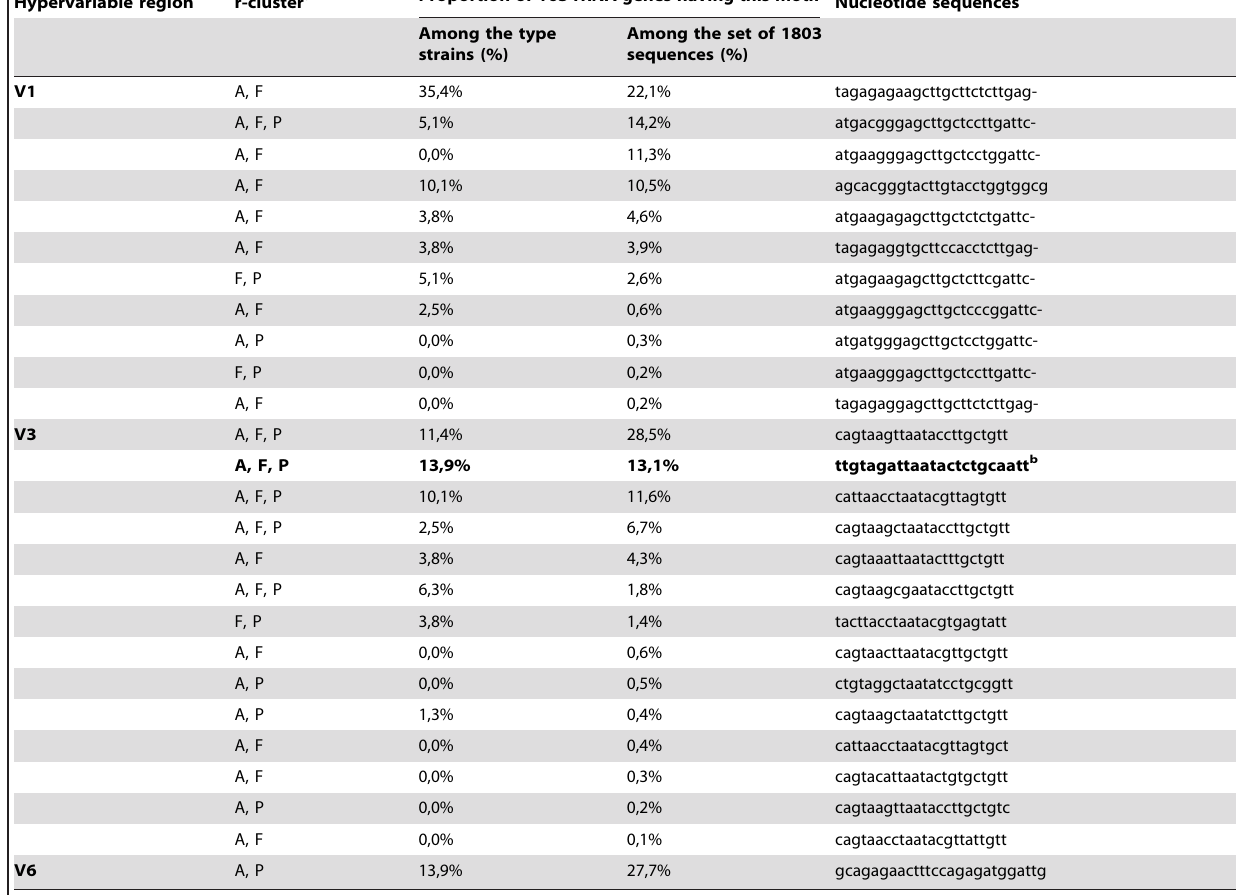
Hypervariable region r-cluster a Proportion of 16S rRNA genes having this motif Nucleotide sequences Among the type strains